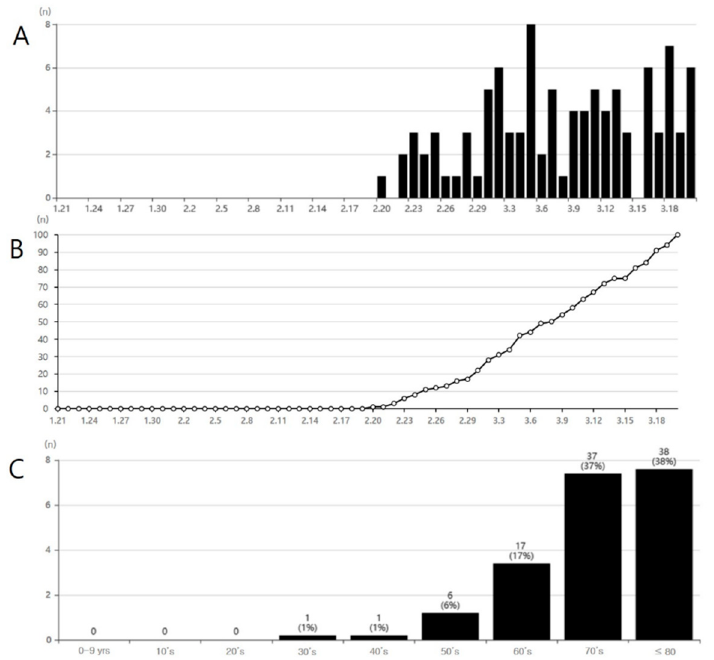
Figure 2. ( A ) Daily number of deaths due to COVID-19 in South Korea, ( B ) daily cumulative number of deaths due to COVID-19 in South Korea, ( C ) number of deaths due to COVID-19 according to age. Source: www.coronaboard.kr.